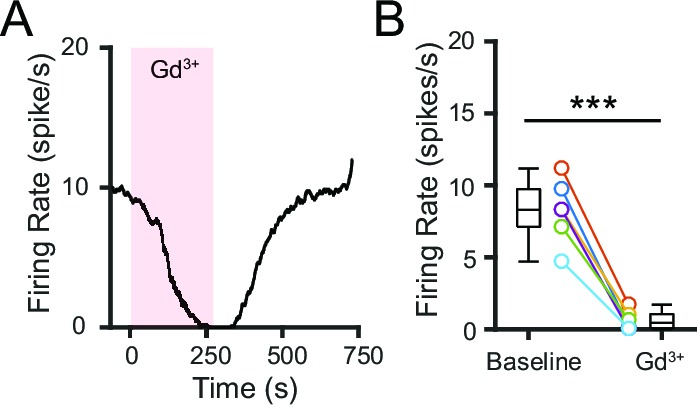
Pharmacological blockade of NALCN impairs SNr firing.(A) Representative time course of SNr neuron firing rate with application of gadolinium (Gd3+; 100 μM). (B) Comparison of firing rates before and after Gd3+ application (8.2 ± 0.9 versus 0.6 ± 0.3 spikes/s; paired t-test; p=0.00018; n = 6). ***p<0.001.